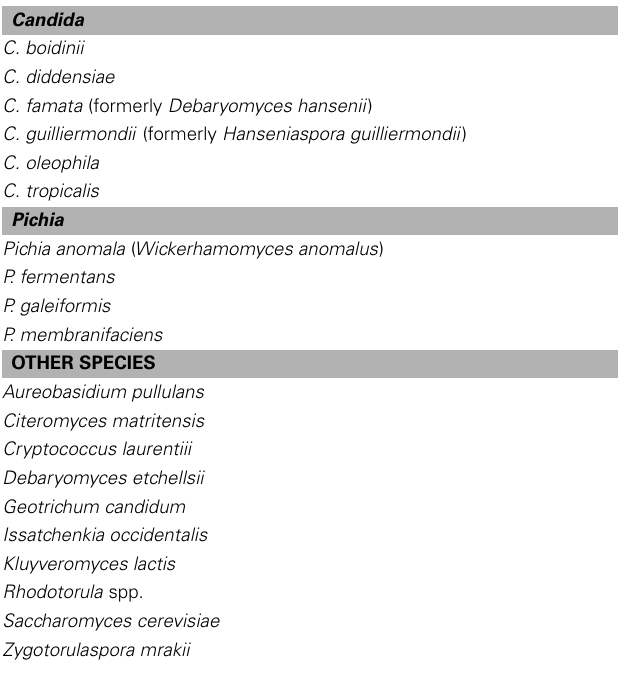
Table 1 |Yeast species in table